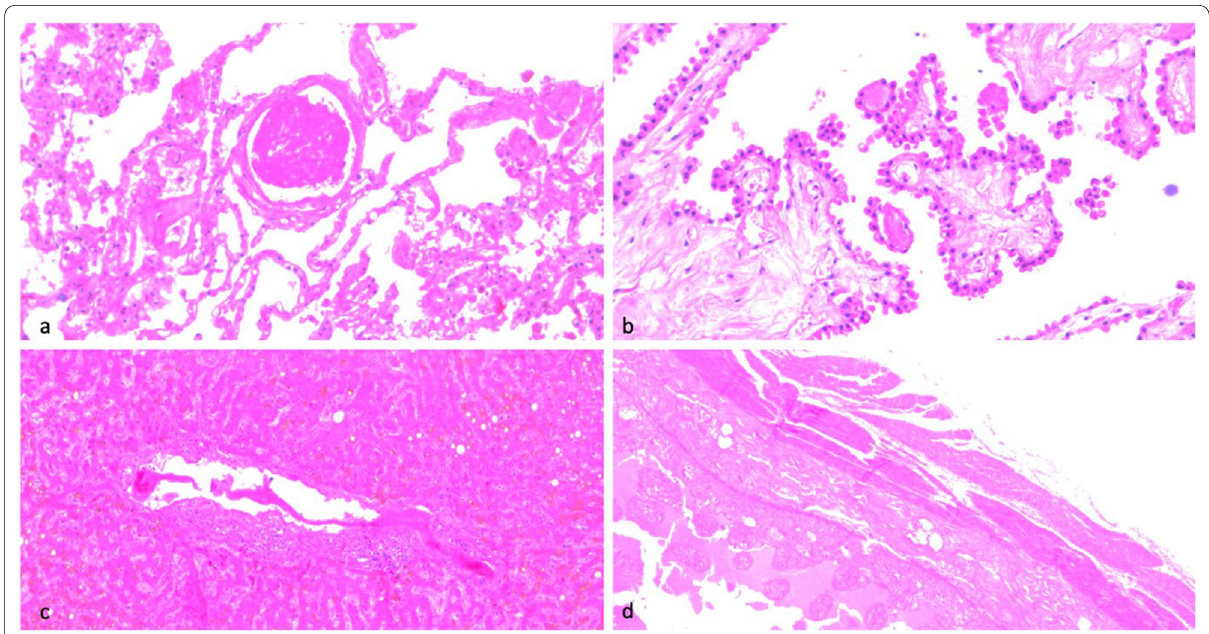
Fig. 8 Histological sample of a patient who developed vaccine-induced immune thrombocytopenia after viral vector vaccine. a Lung. Thrombosis of a small arterial branch. Original magnification 200. b Choroid plexuses. Multiple small thrombi are present inside the capillaries of choroid × plexuses. H&E. Original magnification 200. c Liver. Thrombosis of a portal vein branch. 100. d Ileum. Diffuse severe hemorrhagic necrosis of the × × wall.